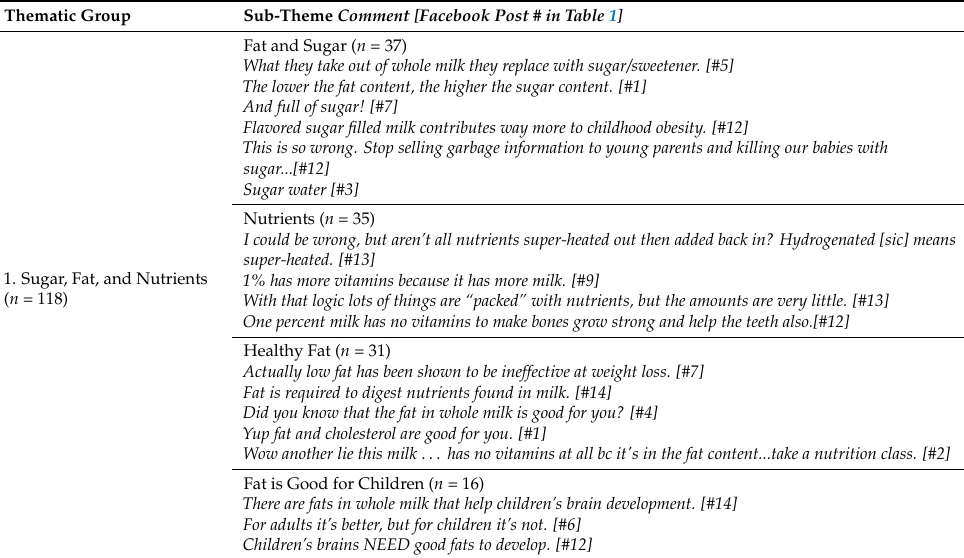
Table 2. Themes and Sub-themes of the Content